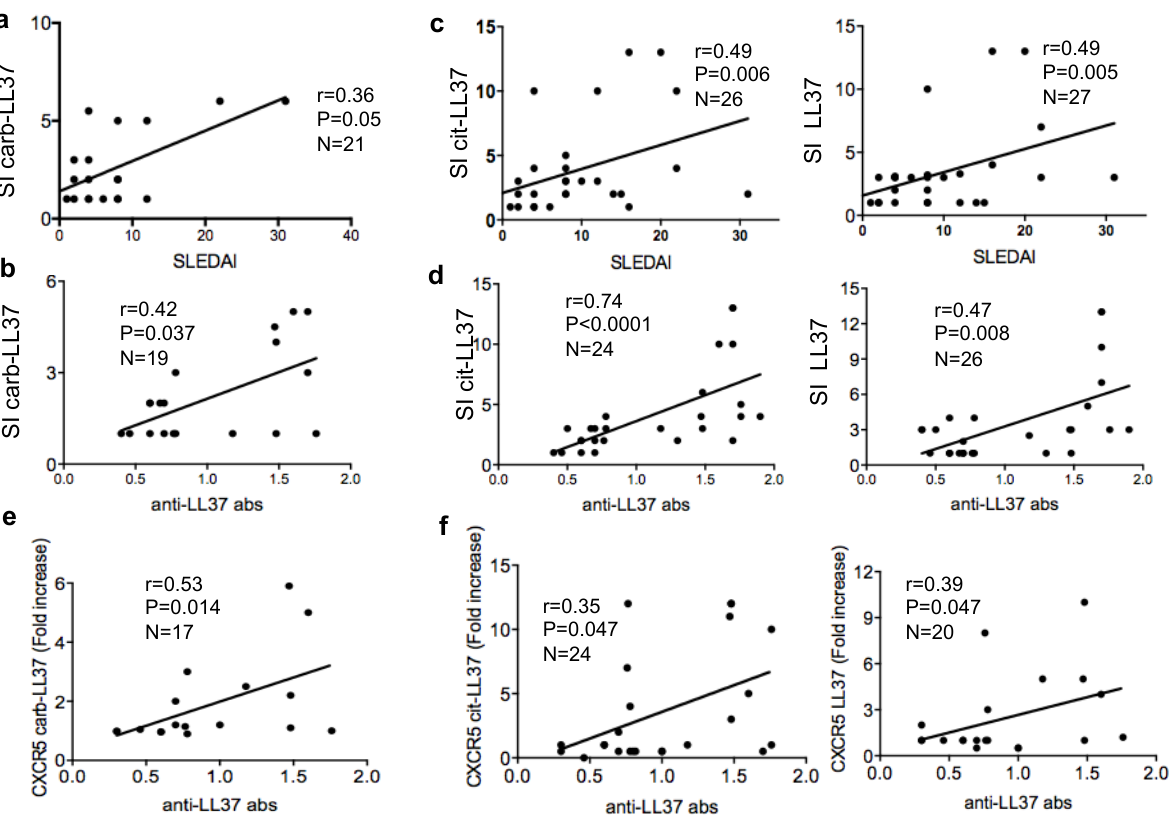
Figure 4. Carb-LL37 proliferating SLE T-cells correlate with SLEDAI and with anti-native LL37 autoantibodies. ( a ) Prolifer- ation to carb-LL37 expressed and SI plotted against SLEDAI or ( b ) anti-native LL37 antibody reactivity (anti-LL37 bas). ( c , d ) Proliferation to cit-LL37 (left panel) or to native LL37 (right panel), expressed and SI, plotted against SLEDAI ( c ) or against anti-native LL37 antibody reactivity ( d ). ( e , f ) CXCR5 expression (as fold-increase with respect to untreated T-cells), in SLE T-cells, in response to carb-LL37 ( e ) or to either cit-LL37 or native LL37 ( f ), plotted against the anti-LL37 antibody reactivity (OD). In all panels Spearman’s r, significance p , sample size N, are